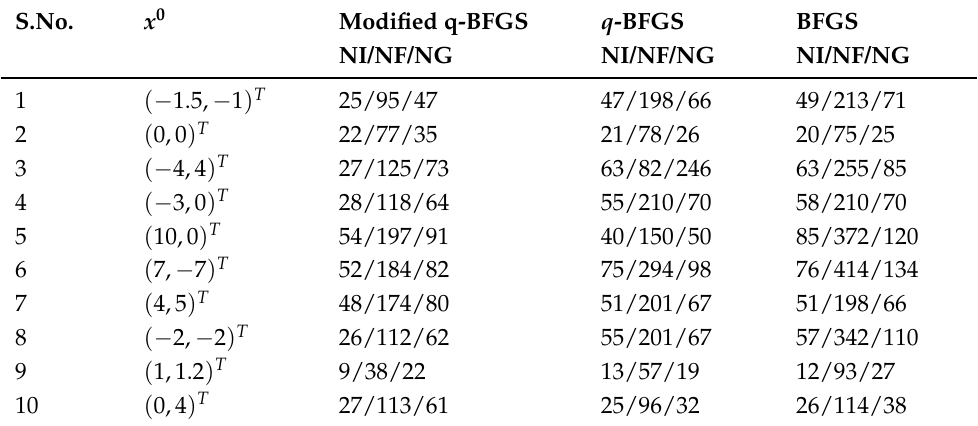
Table 1. Comparison of numerical results of Modified q -BFGS, q -BFGS, and BFGS algorithms for the Rosenbrock function.